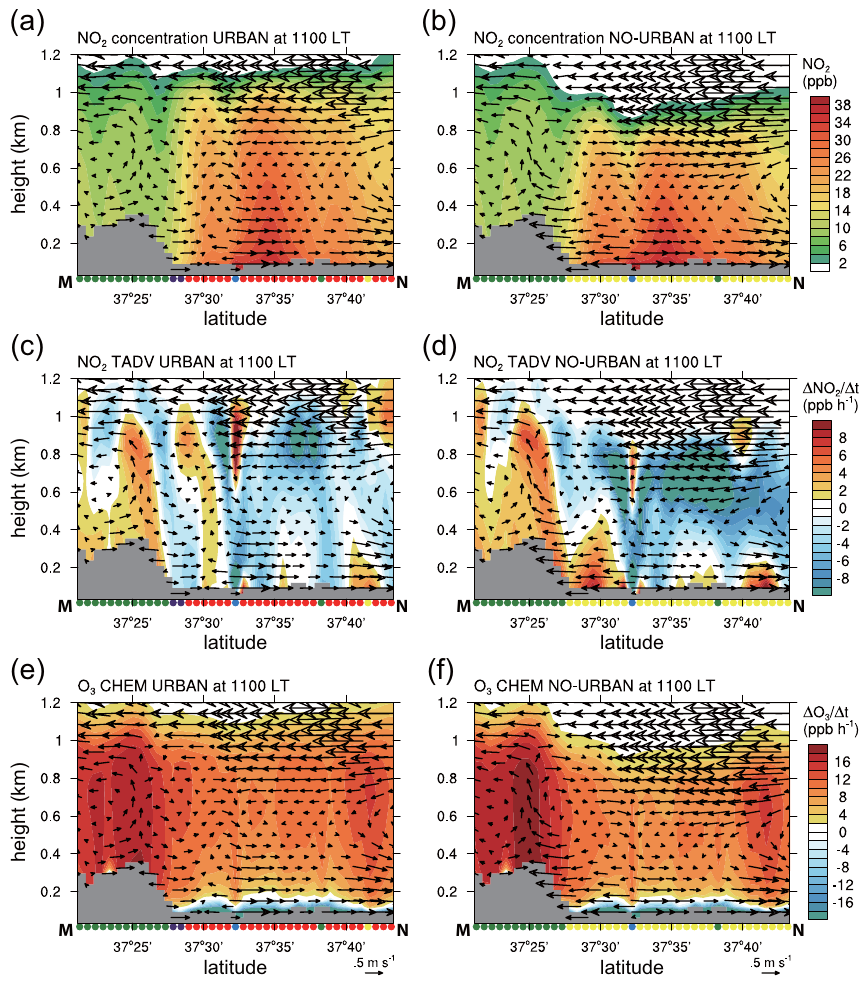
Fig. 8. Vertical cross sections of (a) NO 2 concentration, (c) contribution of the advection process to NO 2 concentration, (e) contribution of the chemical process to O 3 concentration, and wind along the line M–N in Fig. 1d at 11:00 LT in the URBAN simulation. (b) , (d) , and (f) are the same as (a) , (c) , and (e) , respectively, but for the NO-URBAN simulation. The color of circles on the x-axis corresponds to the color of the LULC in Fig.